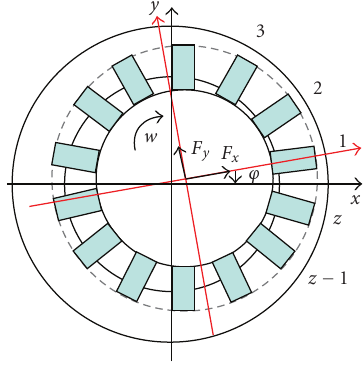
Figure 4: Meshing distance of coupling with misalignment in any direction.